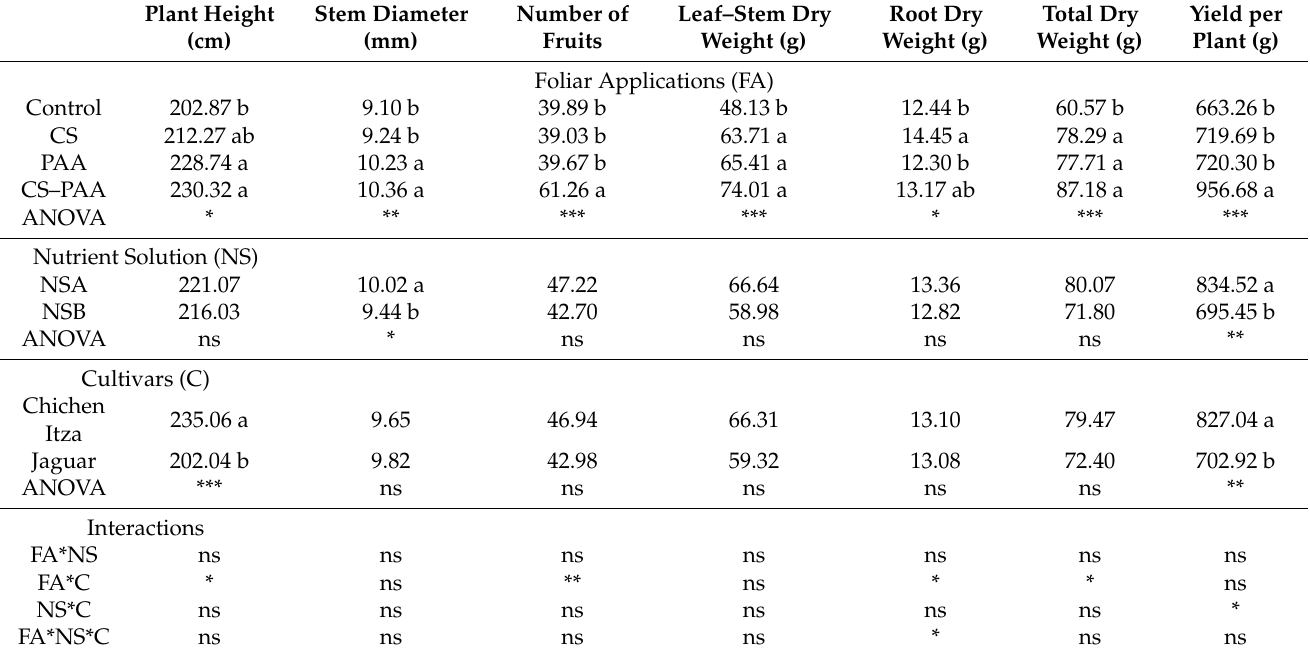
Table 4. Effect of the foliar applications (Control; CS = chitosan; PAA = poly(acrylic acid); and CS–PAA = chitosan–poly(acrylic acid) complexes); nutrient solution (NSA and NSB; see Table 3) and cultivars (Chichen Itza hybrid and Jaguar variety) as well as their interactions on plant height, stem diameter, number of fruits, leaf-stem dry weight, root dry weight, total dry weight, and yield per plant measured 150 days after